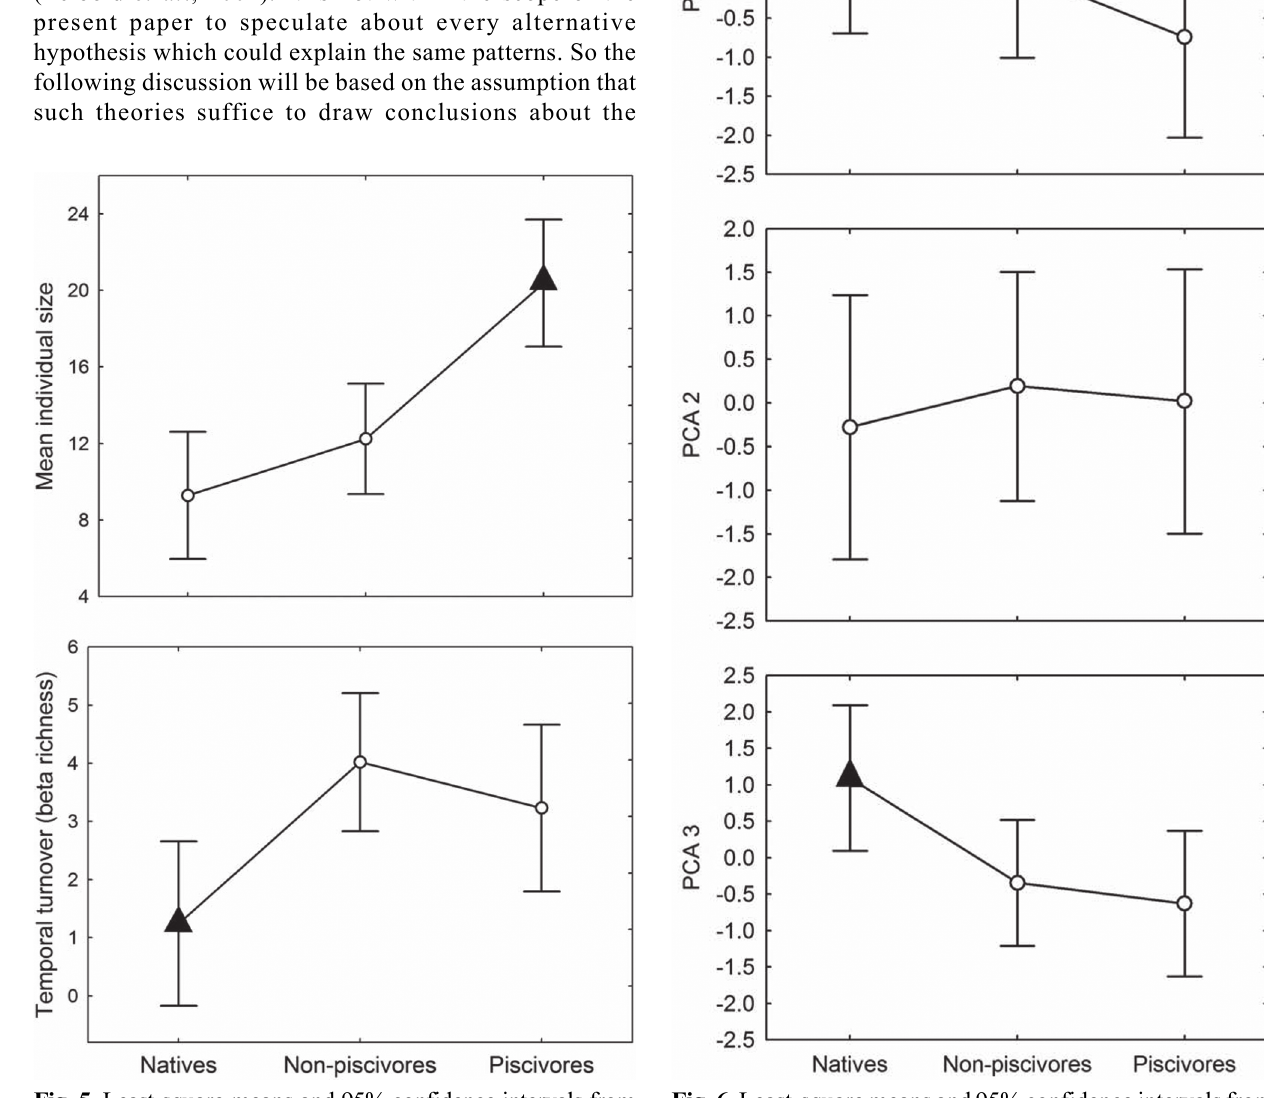
Fig. 6. Least-square means and 95% confidence intervals from ANCOVA of the first three environmental factors from PCA. Different markers represent significantly different means as detected by planned contrasts with 5% significance level, first comparing lakes with any non-native species with those without them, and then comparing the two categories of lakes with non-natives (non-piscivores vs . piscivores).